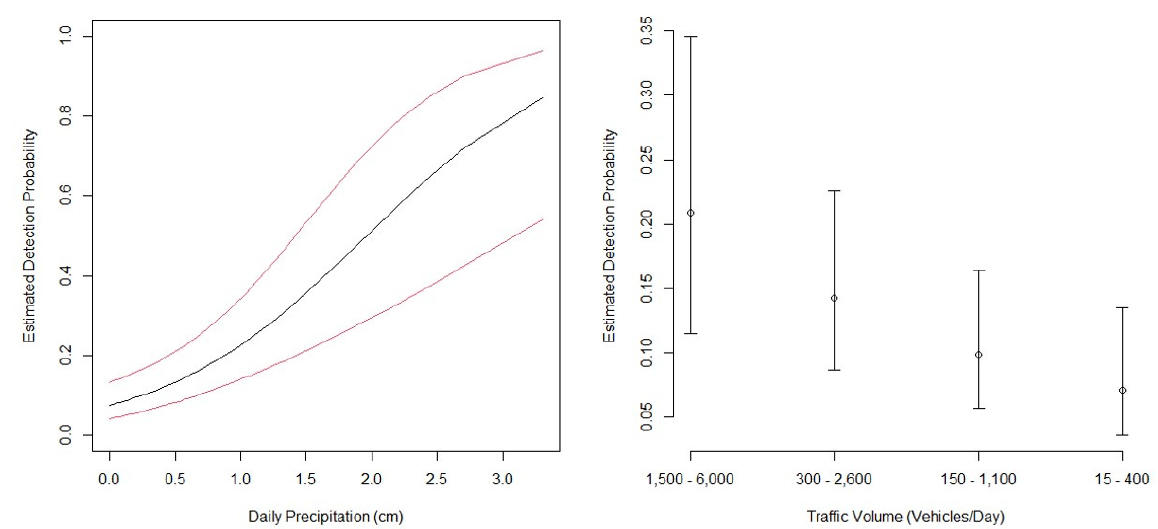
Figure 2. Marginal effect of covariates on estimated detection probability from the model-averaged results. Black lines represent model estimates for detection probability, and red lines represent upper and lower confidence intervals. Plots hold other covariates at their mean value.